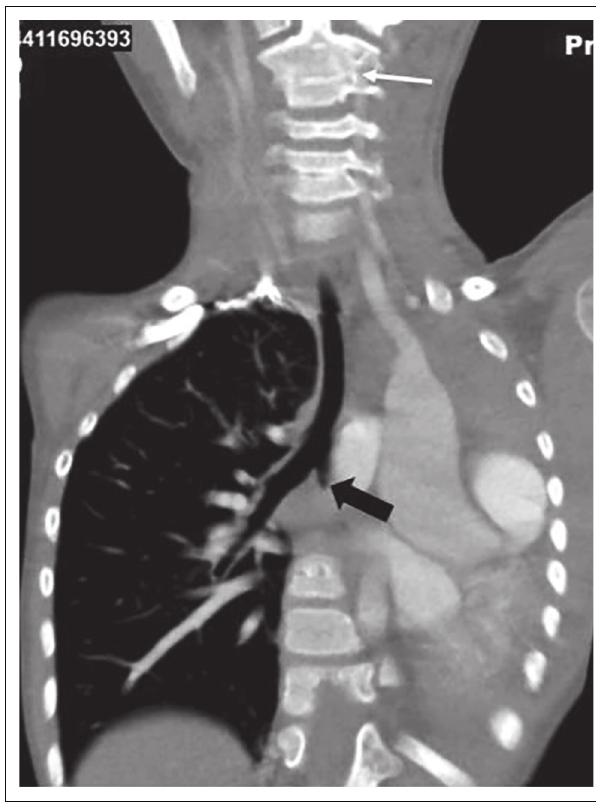
FIGURE 2 : Coronal Computed tomography angiography thorax demonstrates absence of the left lung and pulmonary vessels. The LMB shows abrupt termination after the carina (thick black arrow). The mediastinum is completely displaced to the left side. There is associated fusion of the C2–C3 vertebrae (thin white arrow).